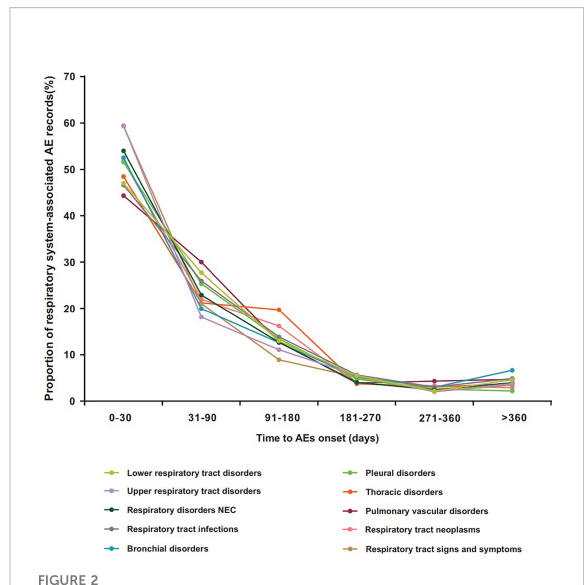
FIGURE 2 Time to onset for ICI-related class-speci fi c respiratory system AEs. AEs, adverse events; ICIs, immune checkpoint inhibitors.